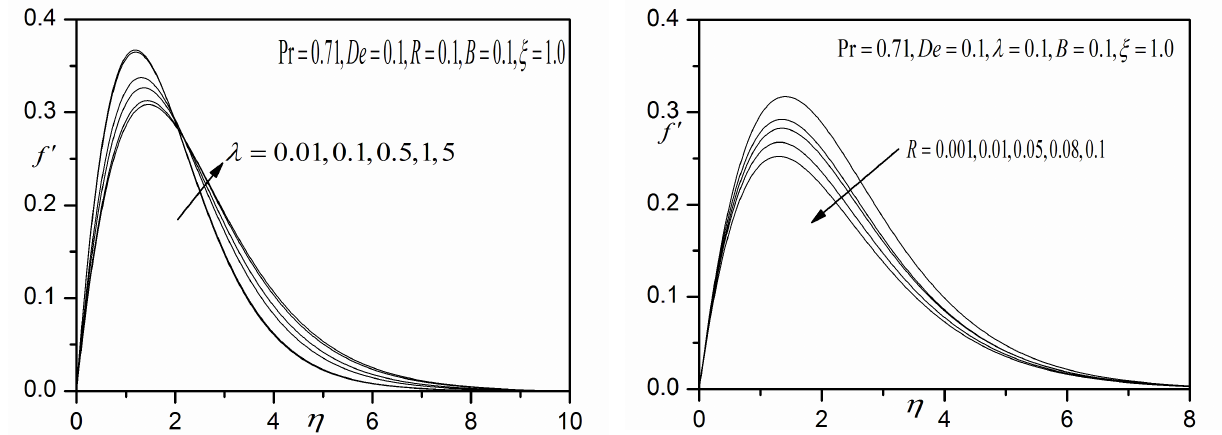
Fig. 8: Influence of R on the velocity.